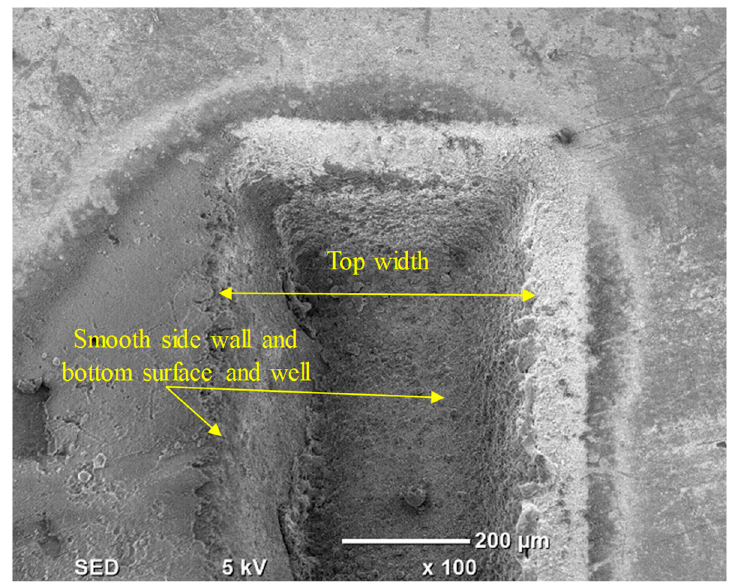
Figure 16. SEM picture of the fabricated microchannel using the optimized GnP reinforcement ratio and laser micromachining parameters .